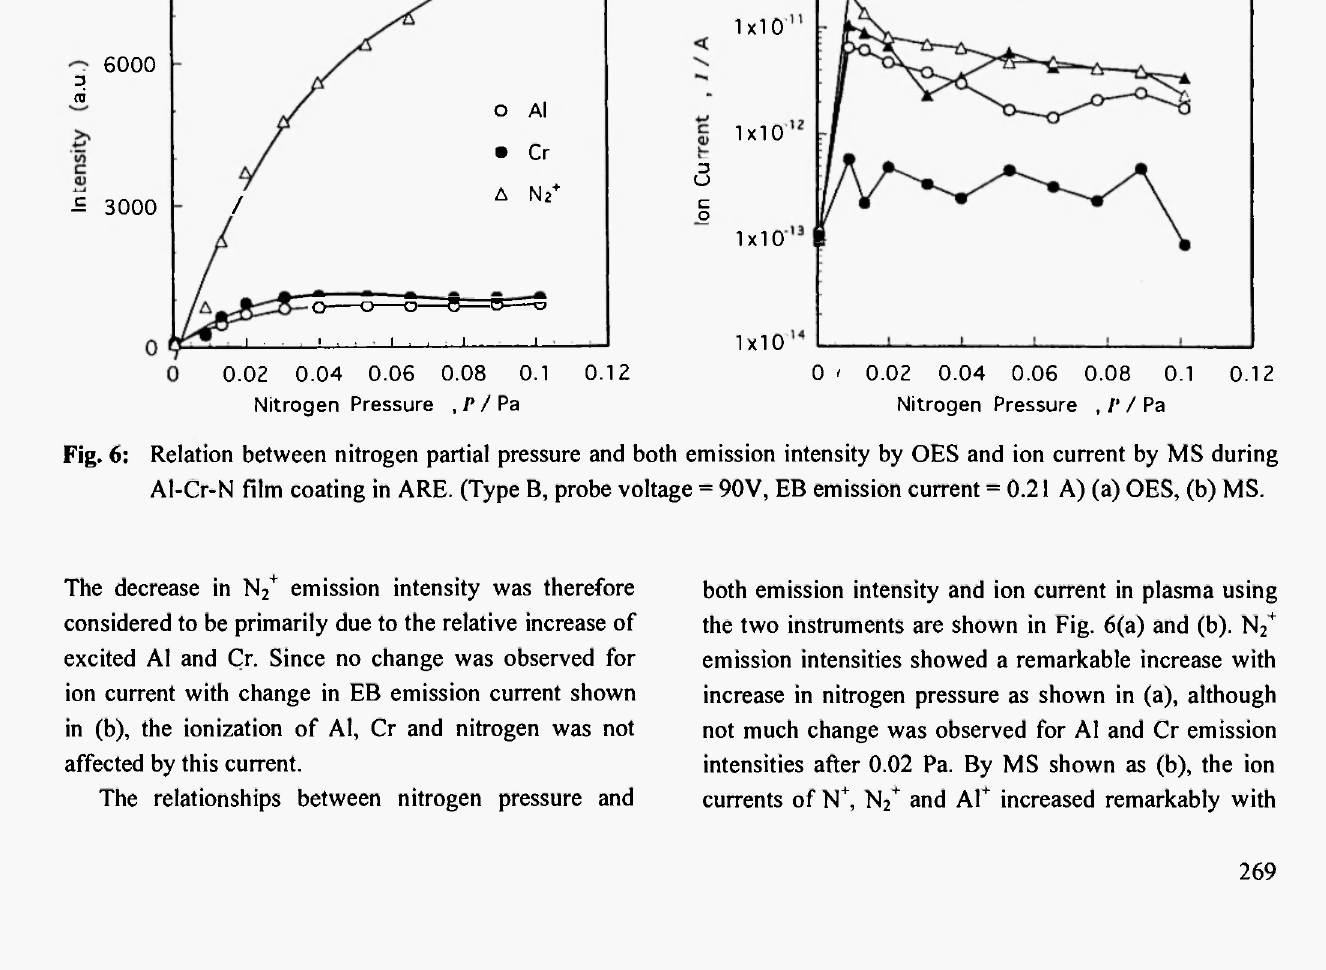
Fig. 6: Relation between nitrogen partial pressure and both emission intensity by OES and ion current by MS during Al-Cr-N film coating in ARE. (Type B, probe voltage = 90V, EB emission current = 0.21 A) (a) OES, (b) MS.